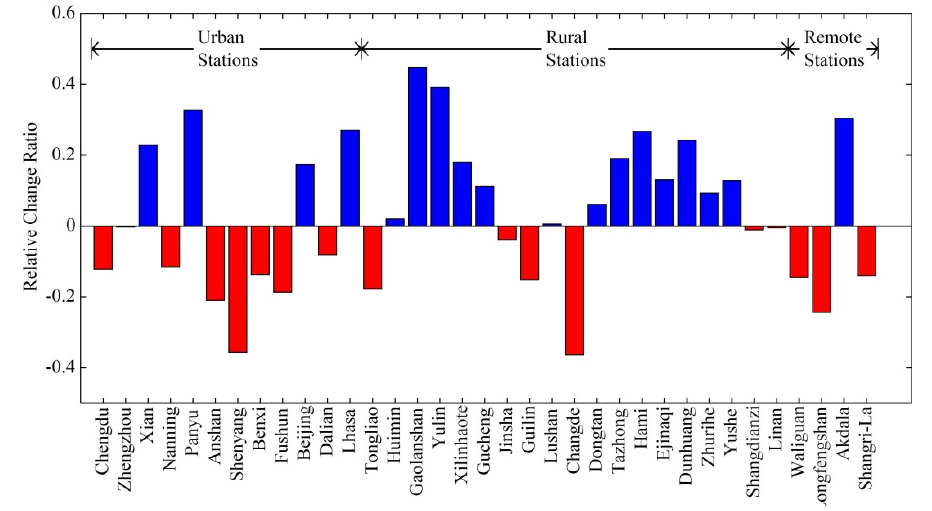
Figure 9. Change ratio of the mean value of the revised data compared with the mean value of original data. original